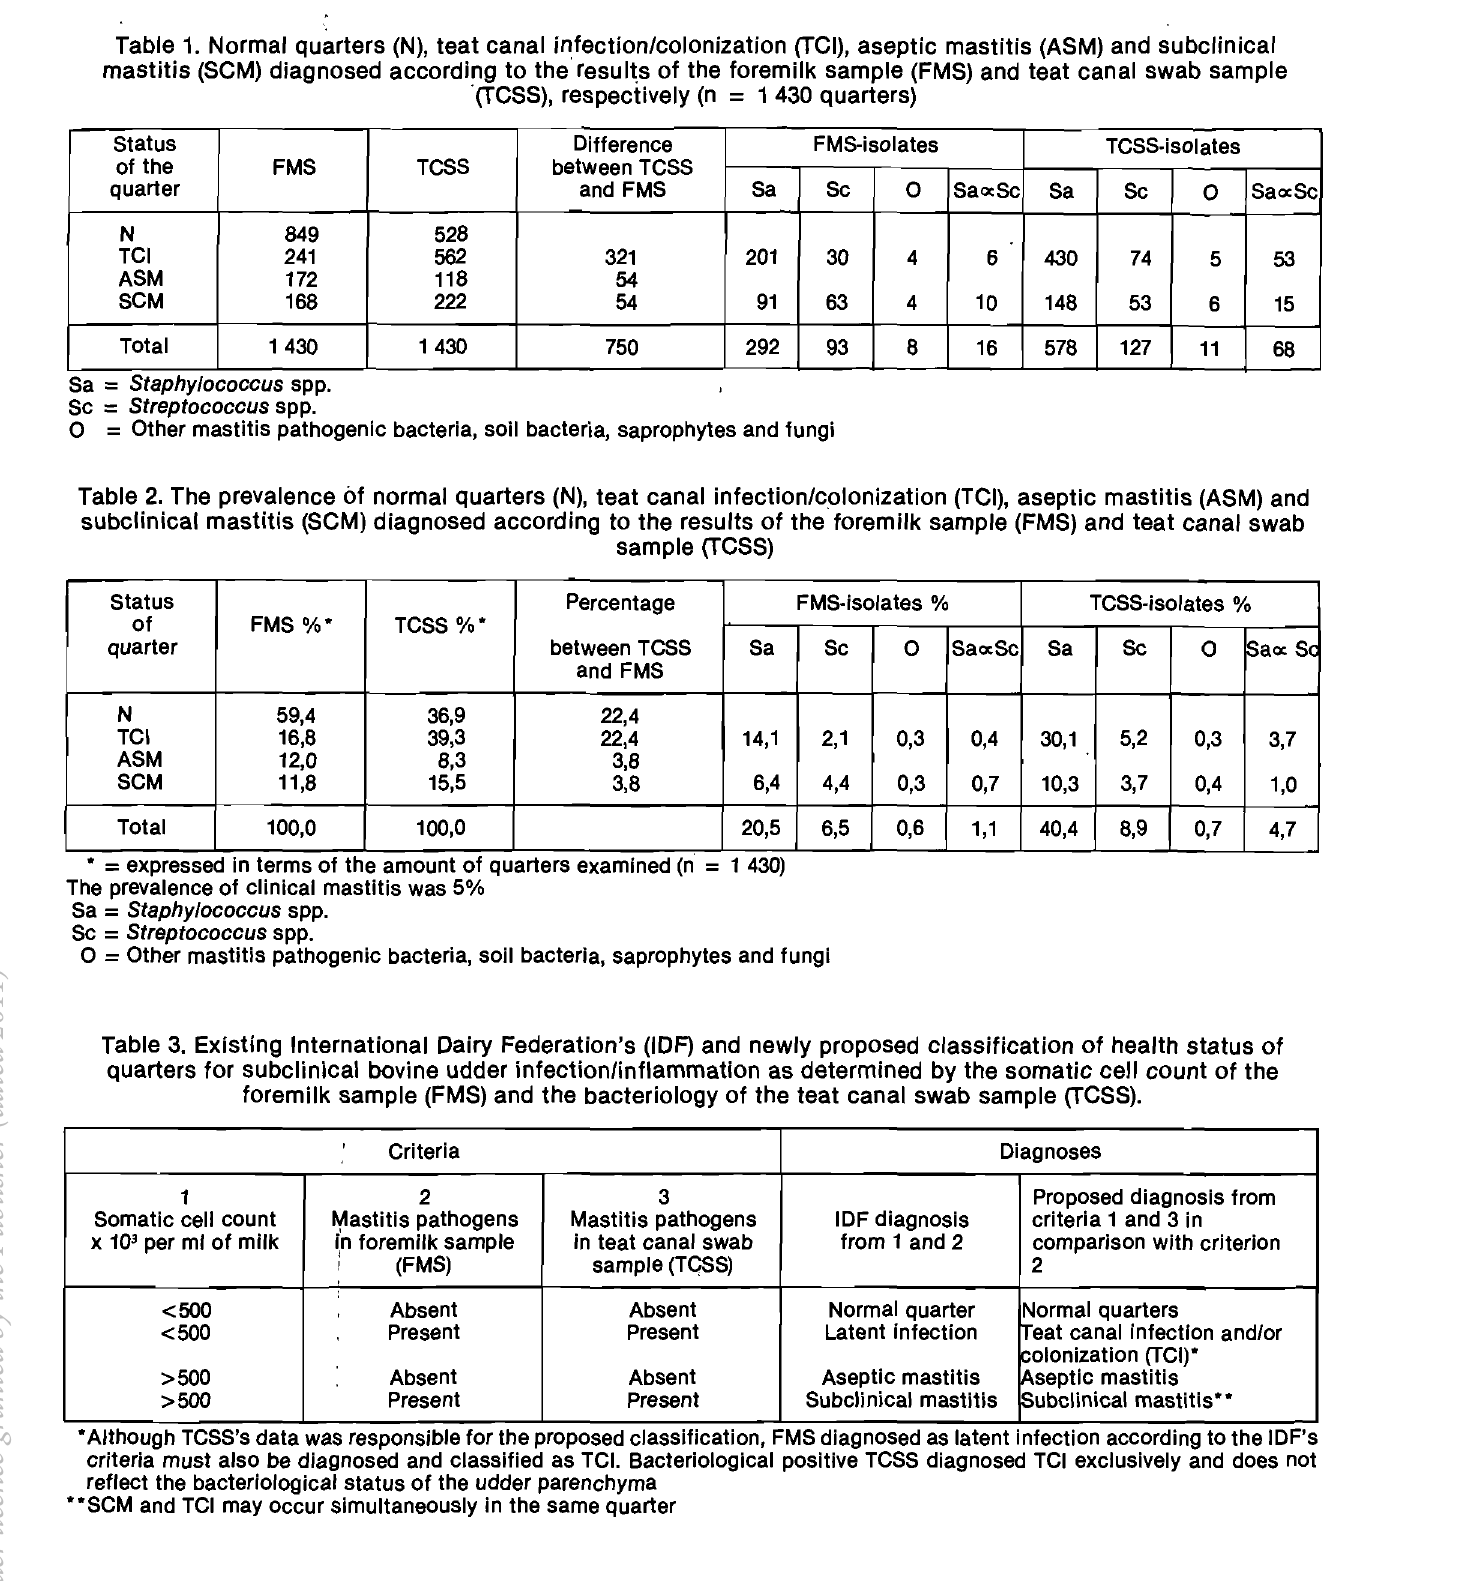
Table 1. Normal quarters (N), teat canal infection/colonization (TCI), aseptic mastitis (ASM) and subclinical mastitis (SCM) diagnosed according to the result.s of the foremilk sample (FMS) and teat canal swab sample = (TCSS), respectively (n 1 430 quarters) Status of the